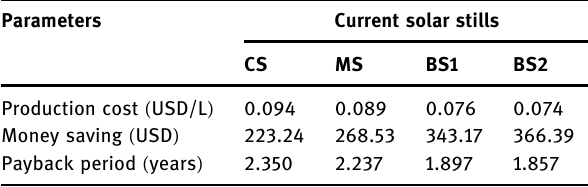
Figure 17: The total thermal e ffi ciency.